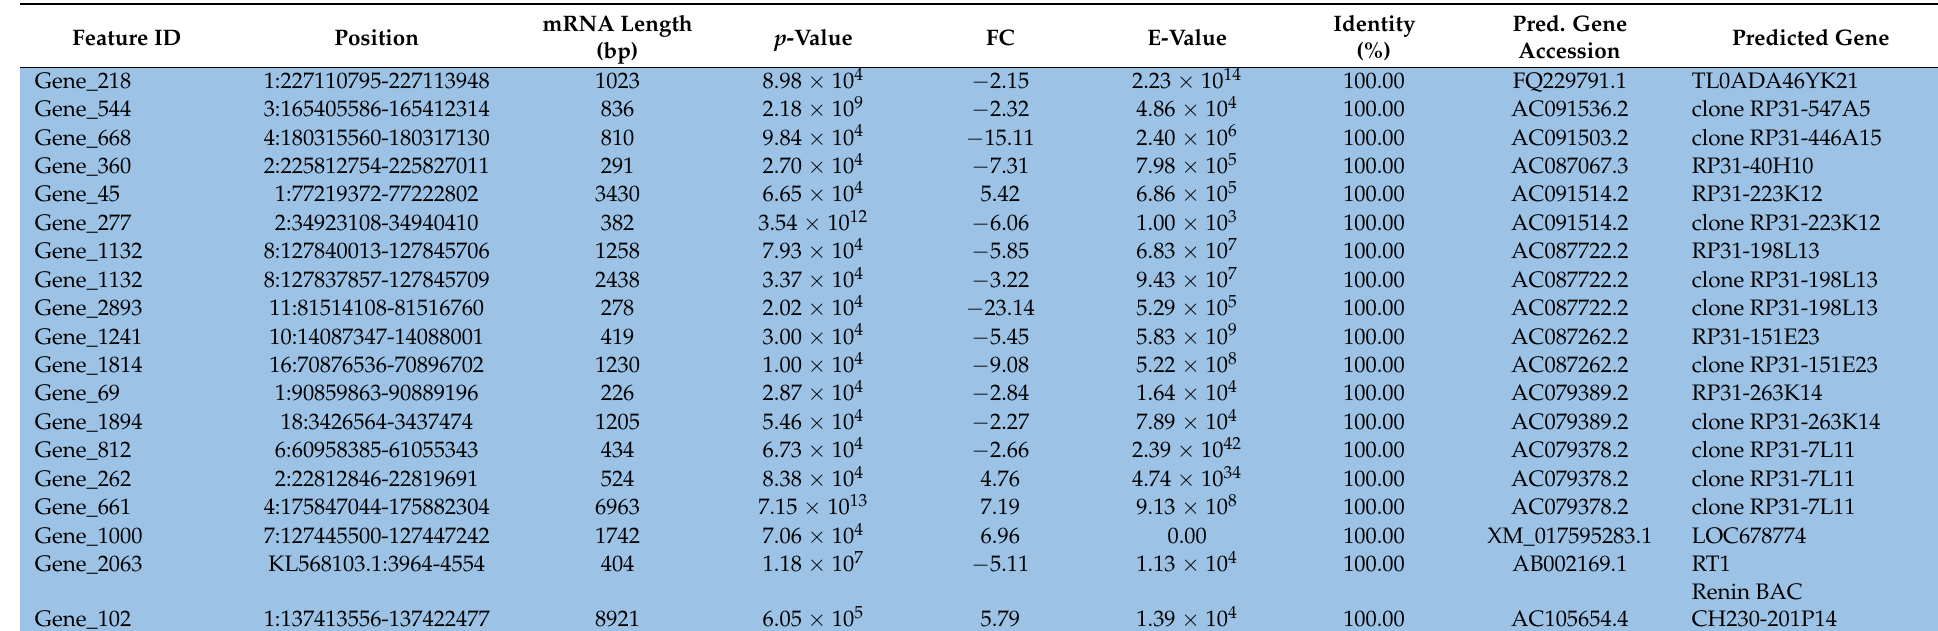
Table 3. Differentially expressed novel transcripts associated with non-annotated genes in the